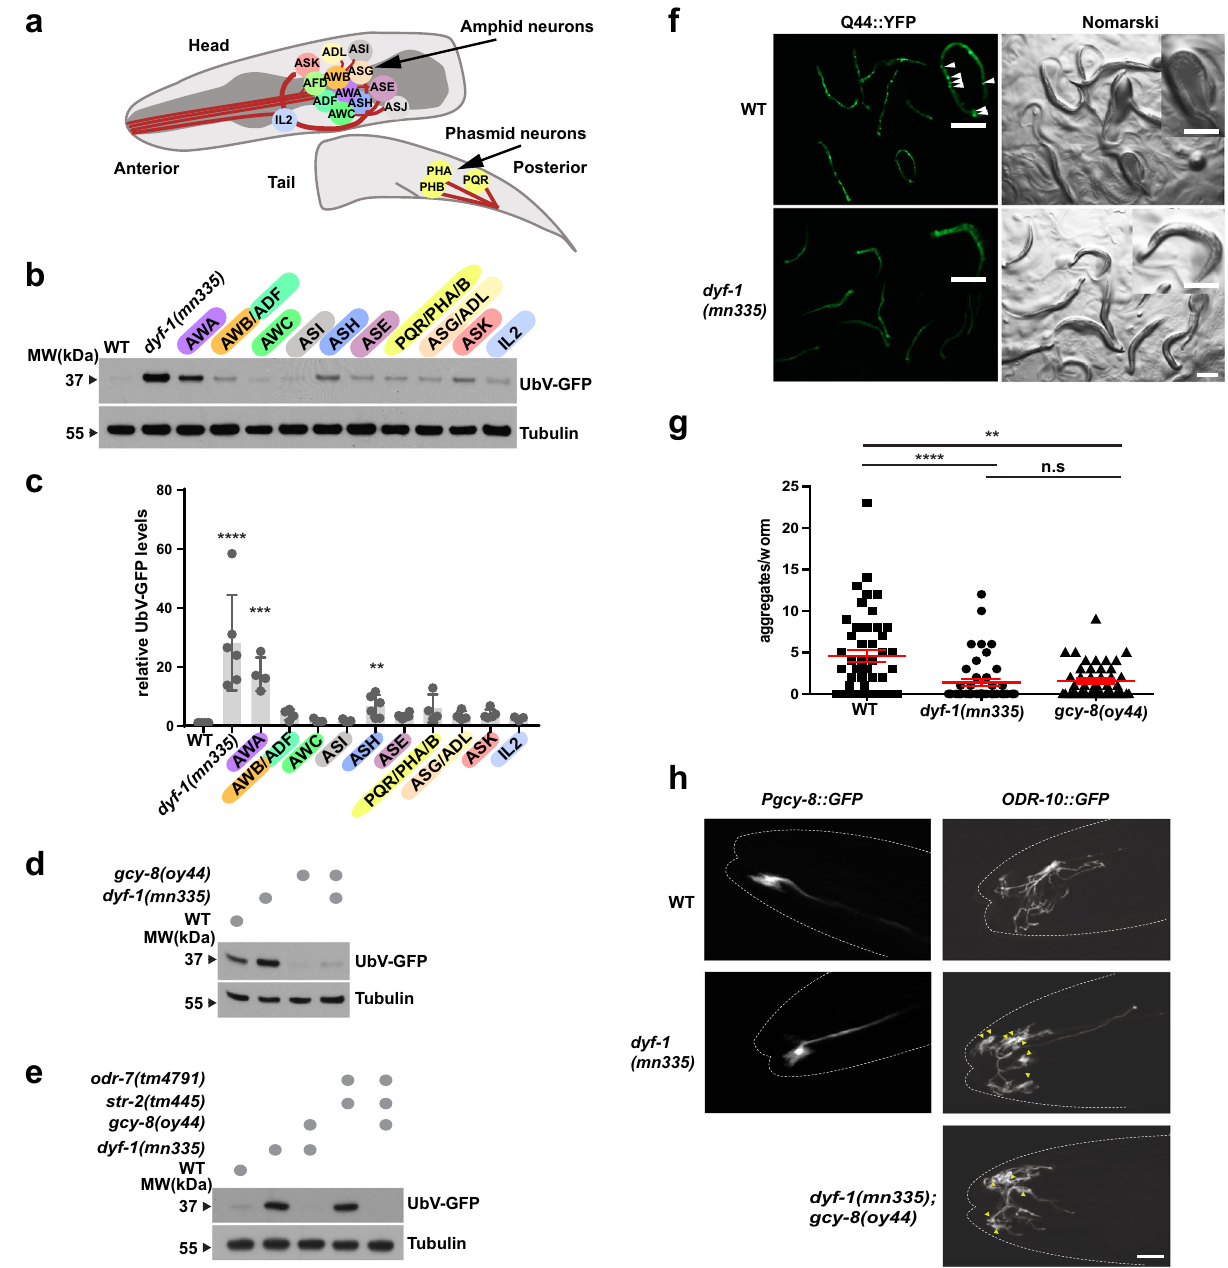
Fig. 2 | Neuronal signalling controls ubiquitin-dependent turnover and PolyQ aggregation. a Schematic illustration of analysed C. elegans ciliated head and tail neurons. b WT, dyf-1(mn335) , or worms harbouring mutations affecting the func- tionality of indicated neurons and expressing UbV-GFP were analysed by Western blotting against GFP and tubulin. Mutants: AWA odr-7(tm4791) , AWB/ADF lim4(ky403) , AWC ceh-36(ks86) , ASI unc-3(e151) , ASH unc-42(e270) , ASE che-1(ot75) , PQR, PHA, PHB ceh-14(ch3) , ASG/ADL lin-11(n389) , ASK ttx-3(ot22) , and IL2 unc-86 (n847) . c Quanti fi cationofwormsfrom( b ), n =6(WT, dyf-1 ,ASH,ASE),5(ASI,ASK), 4 (AWA, AWB/ADF, PQR, PHA, PHB, ASG/ADL) and 3 (IL2, AWC) biologically inde- pendent experiments. Column graphs: mean±standard deviation, scatter plots: individual experiments, dyf-1(mn335) p =<0.0001, odr-7(tm4791) p =0.001 (includ- ing dyf-1(mn335) for maximum changes), lim4(ky403) p =0.5413, ceh-36(ks86) p =0.9996, unc-3(e151) p =0.9996, unc-42(e270) p =0.0067, che-1(ot75) p =0.6447, ceh-14(ch3) p =0.0528 , lin-11(n389) p =0.708, ttx-3(ot22) p =0.4099, unc-86(n847) p =0.9867 (excluding dyf-1(mn335) from comparison to detect signi fi cant